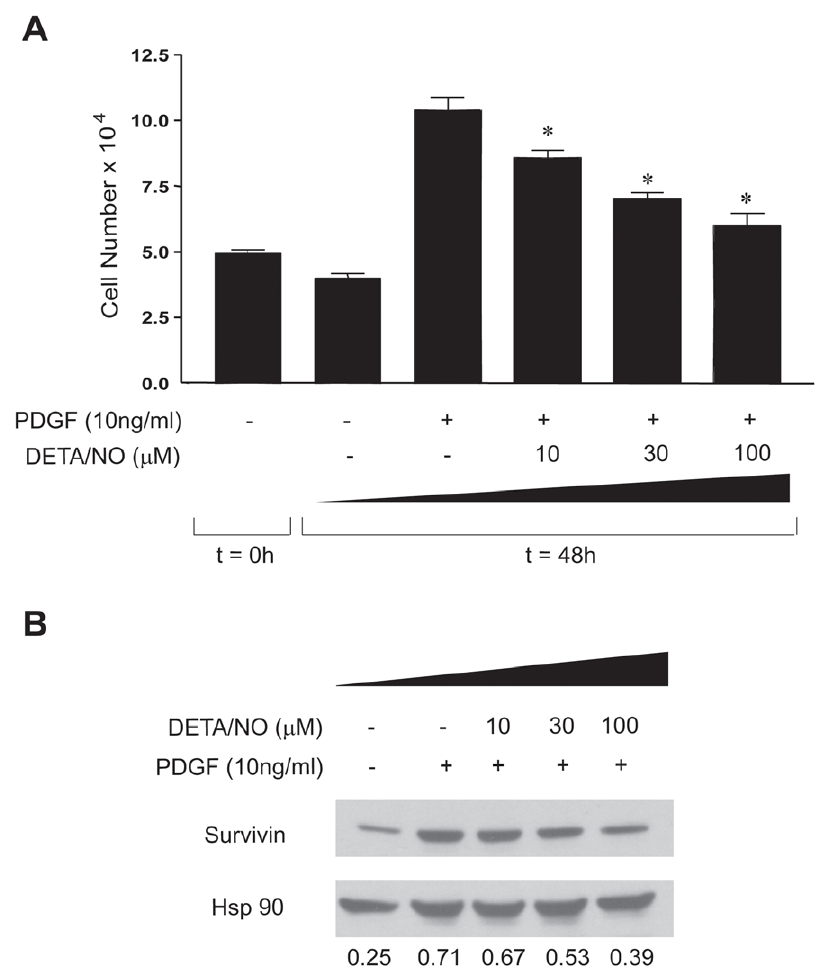
Figure 5. NO donor dose dependently decreases cell number induced by PDGF-BB and blocks survivin expression and invitro . (A), Rat SMC were treated or not with PDGF (10 ng/ml), in the absence or presence of the NO donor, DETA/NO (10, 30, and 100 m M) and cell number quantified after 48 h. (B), NO reduces PDGF induced survivin levels. VSM were treated with PDGF (10 ng/ml) with or withoutt DETA/NONO (10, 30 and 100 m M) and the levels of survivin assessed by Western blotting. DETA/NO dose dependently decreased survivin levels relative to Hsp90 (a protein loading control). Densitometric values of the ratio of survivin to Hsp90 are shown below the blots. * P , 0.05, ** P , 0.01 with one way ANOVA with Bonferroni